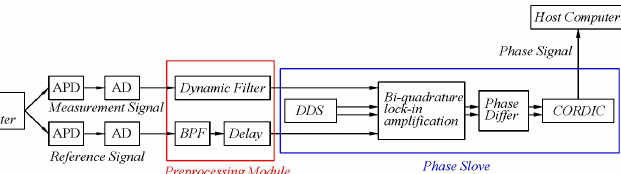
Figure 2. Block diagram of subnanometer heterodyne interference signal processing algorithm with a dynamic filter.